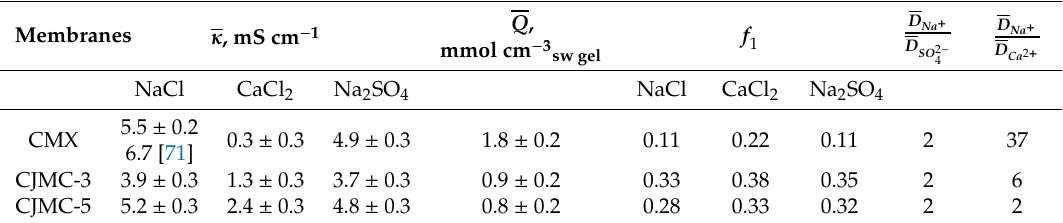
Table 2. The values of the electrical conductivity at the isoconductivity point, κ , volume fraction, f 1 , and exchange capacity of the gel phase, Q , of the investigated